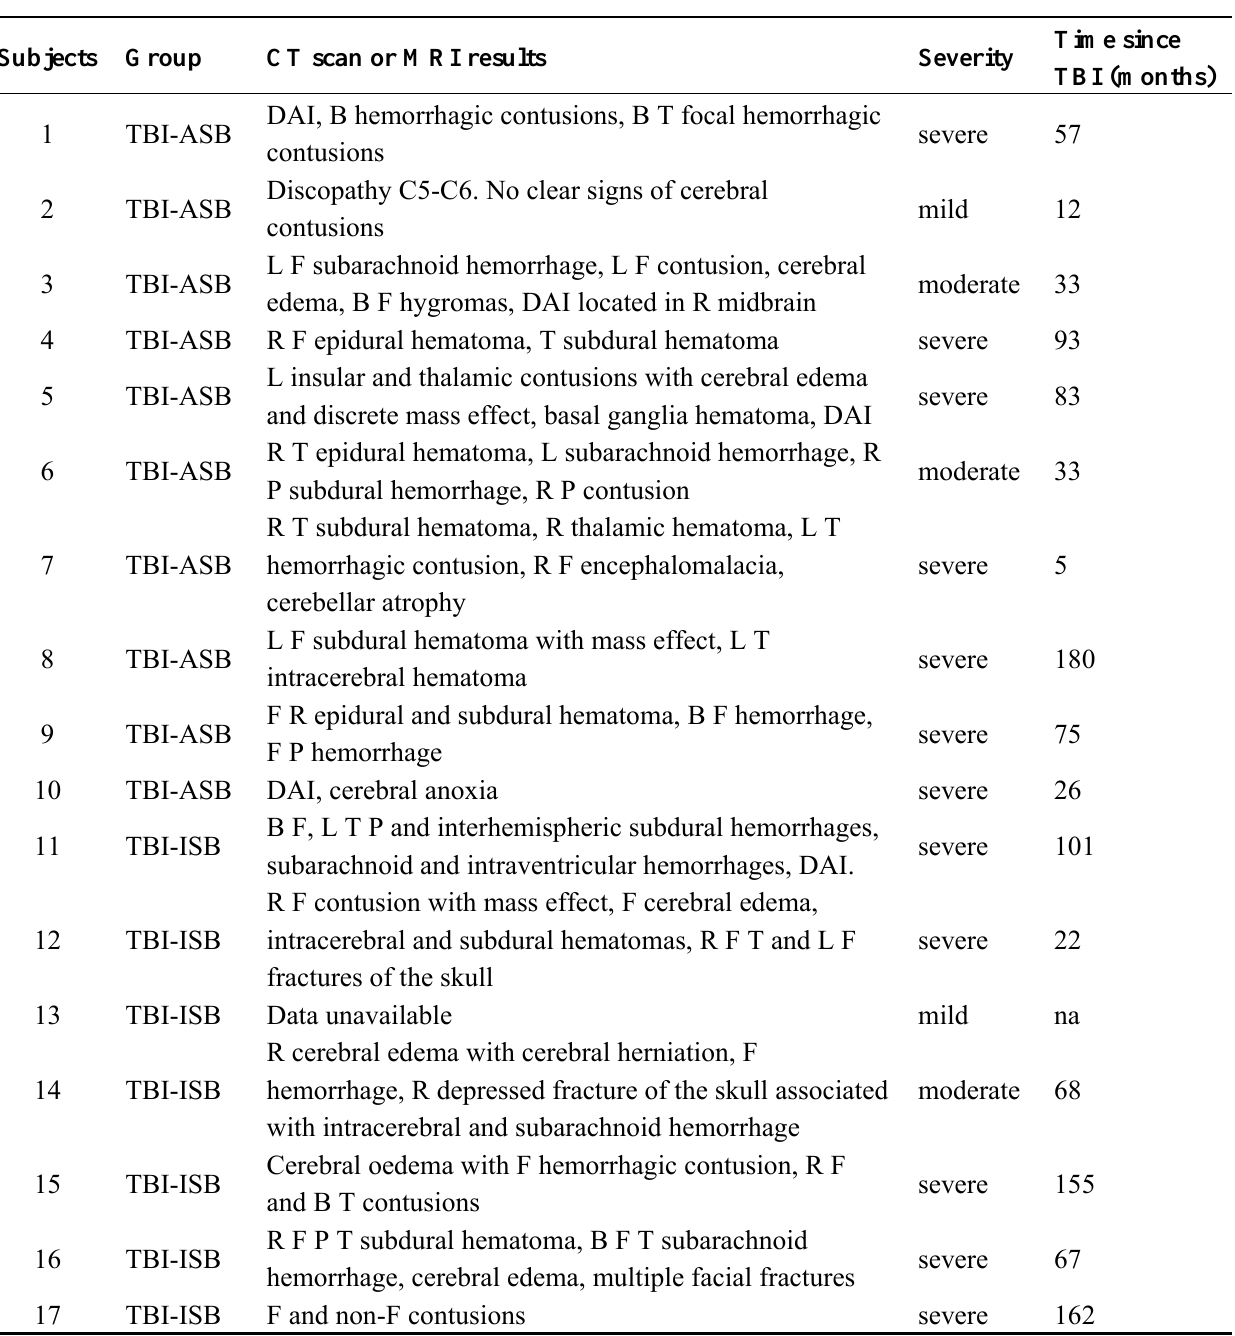
Table 1. Clinical description of the TBI